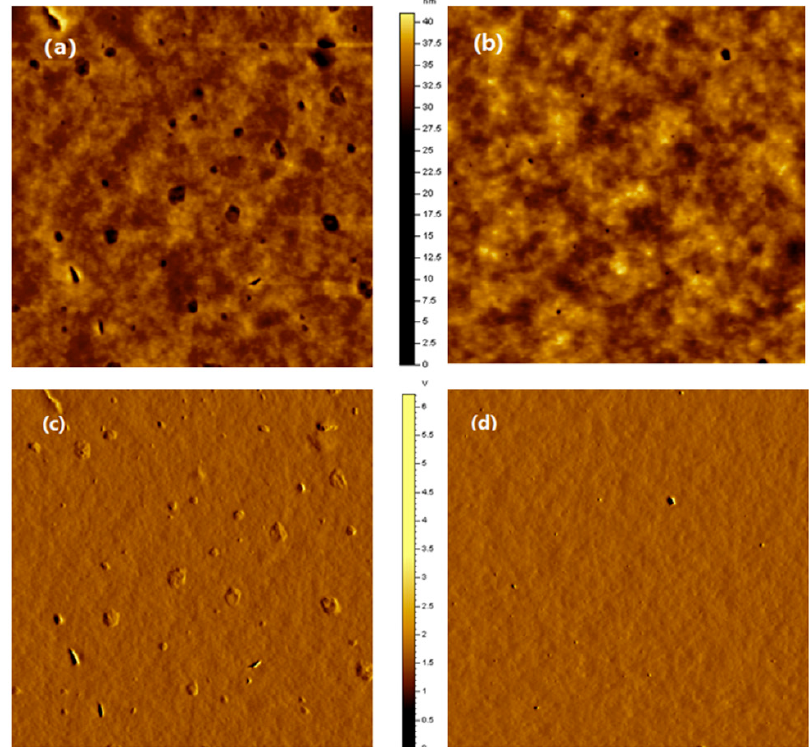
Figure 6. Atomic force microscopy (AFM) height images (upper row) and phase images (lower row)